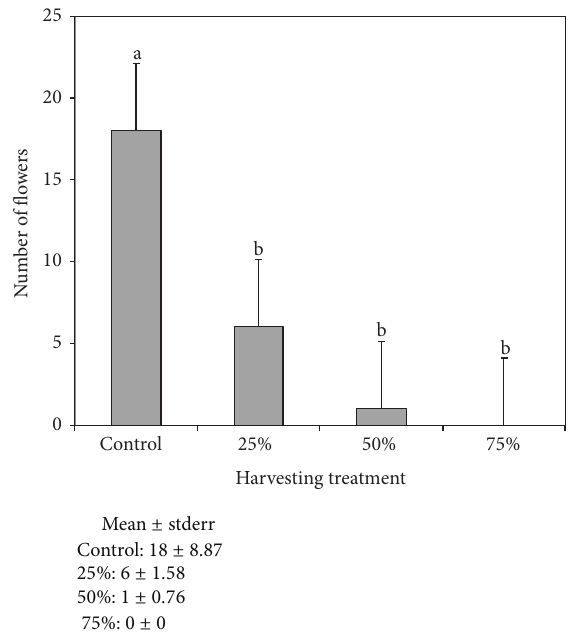
Figure 5: Effect of foliage harvest intensity on number of flowers of T. daniellii . Means ( ± SE) with different letters differ significantly at 5% probability level.